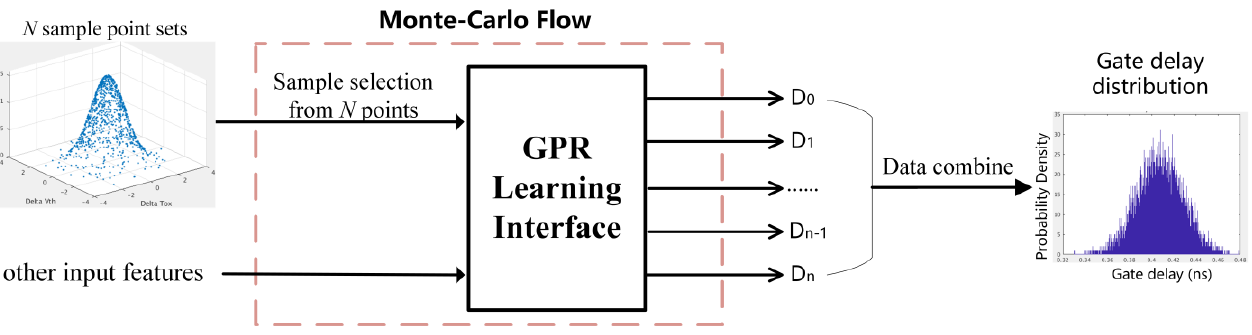
Figure 3. The SGDE framework using GPR learning interface. As a whole, SGED can transfer both the NBTI and PV effects to the gate delay. The leftmost image in Figure 2 is the normalized probability density of a joint Gaussian distri- bution by ∆ V th 0 and ∆ T ox , and the rightmost image is the probability density of gate